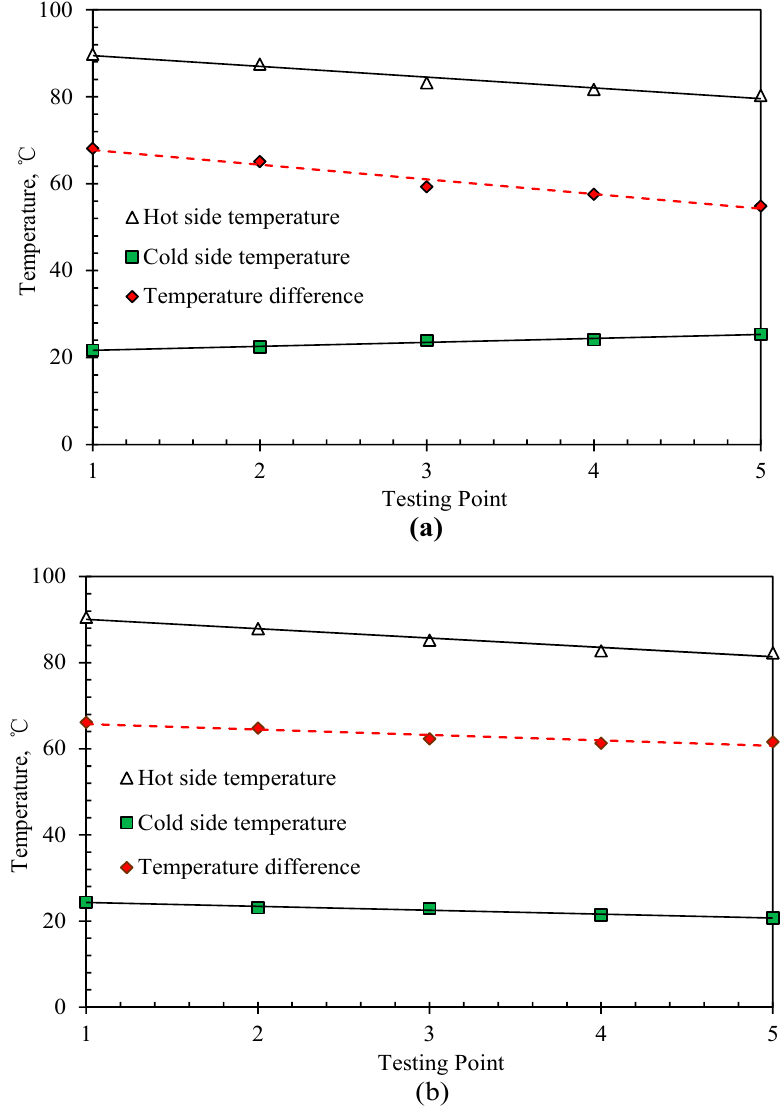
Figure 13. Temperature and temperature difference of each testing point for different flow direction: ( a ) Co-current; ( b ) Counter current.